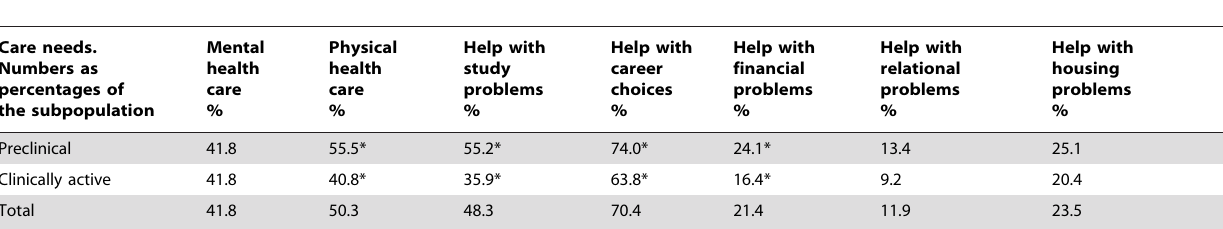
Table 4. Students’ need for availability of different forms of care as a percentage of the total population and of the preclinical and clinical